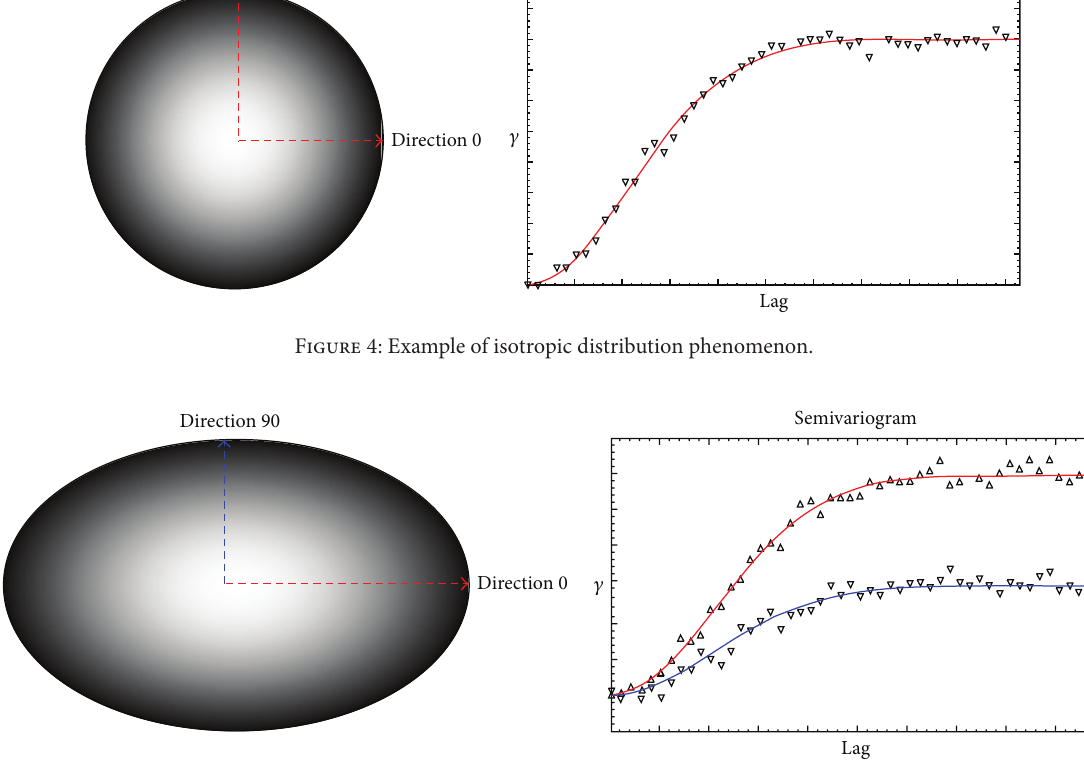
Figure 5: Example of an anisotropic distribution